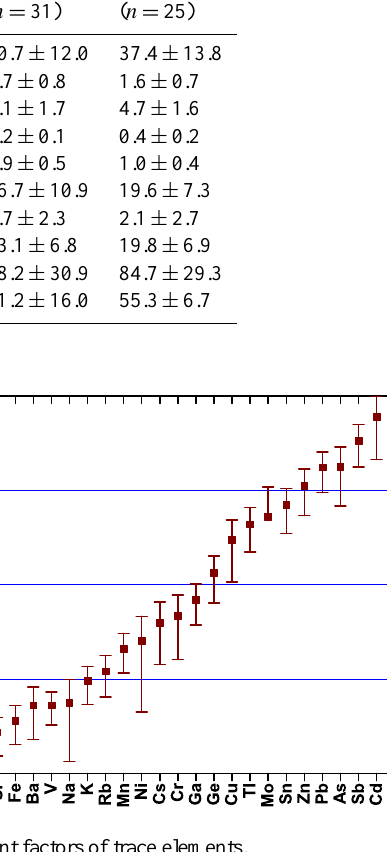
Table 3. The calculated chemical components and phase state of ions (µgm − 3 ) in lab condition (temp: 23 ◦ C; RH: 40%) in Chengdu. Results were modeled by the ISORROPIA II. Annual Spring Summer Autumn